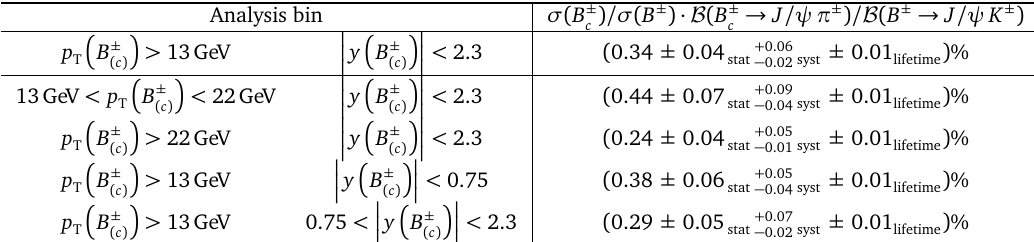
Table 1: Summary of the measured production cross section times branching ratio → J /ψπ ± relative to B ± → J /ψ K ± in the respective analysis bins [ 3 ] . for B ± c Analysis